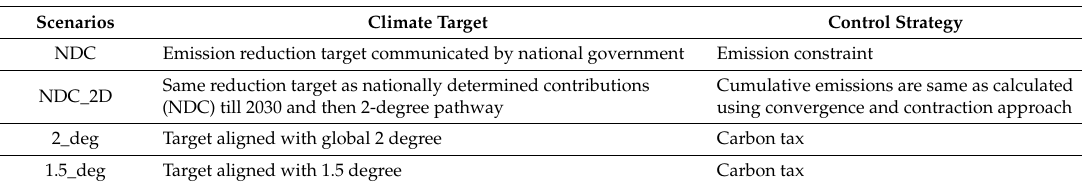
Table 1. Scenario